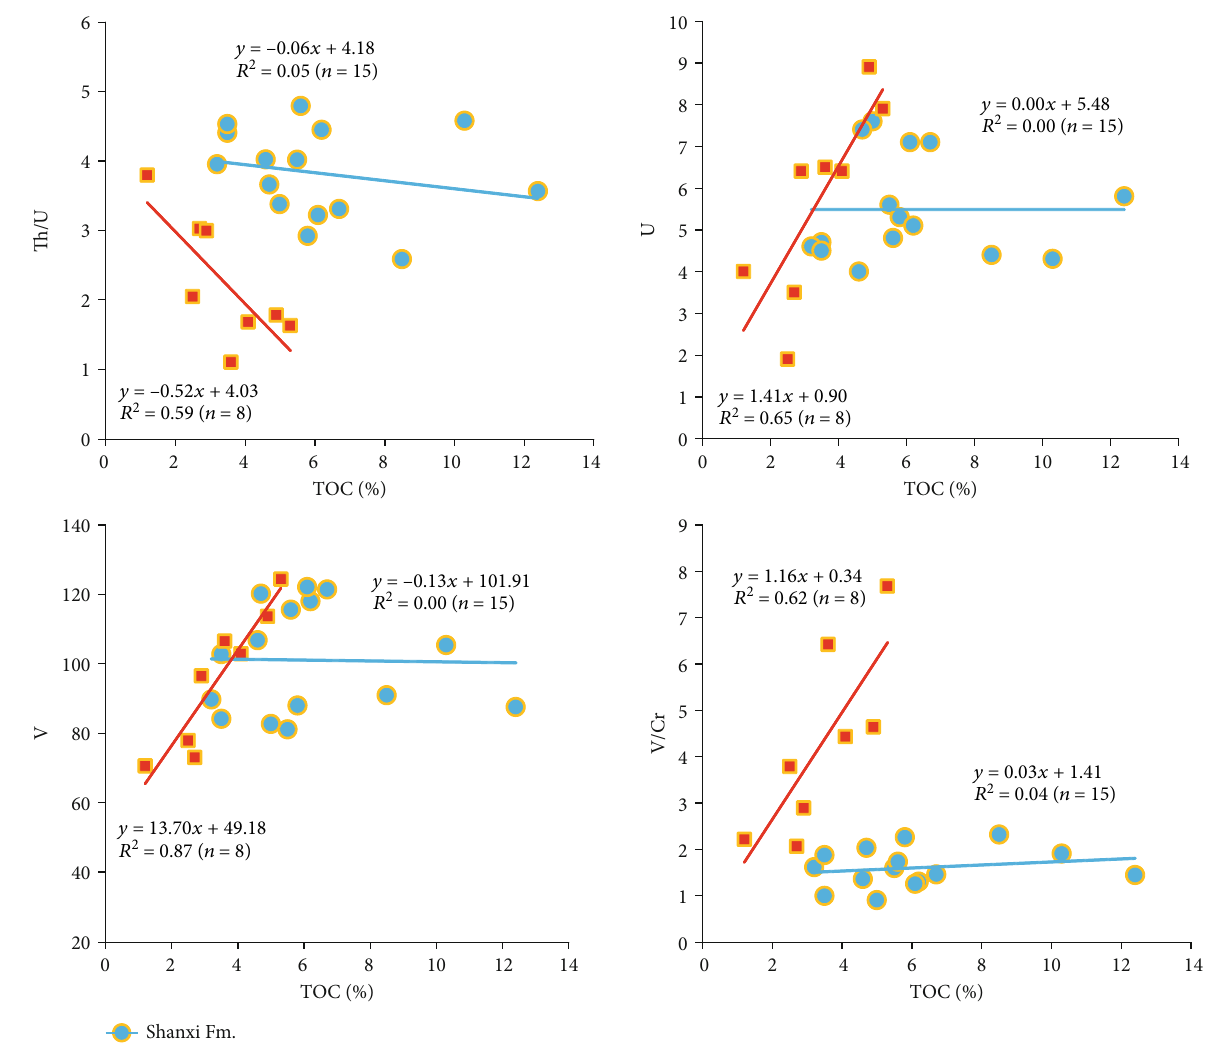
Figure 5: Crossplots of TOC content versus redox proxies (Th/U, U, V, and V/Cr) of the samples in the Taiyuan and Shanxi